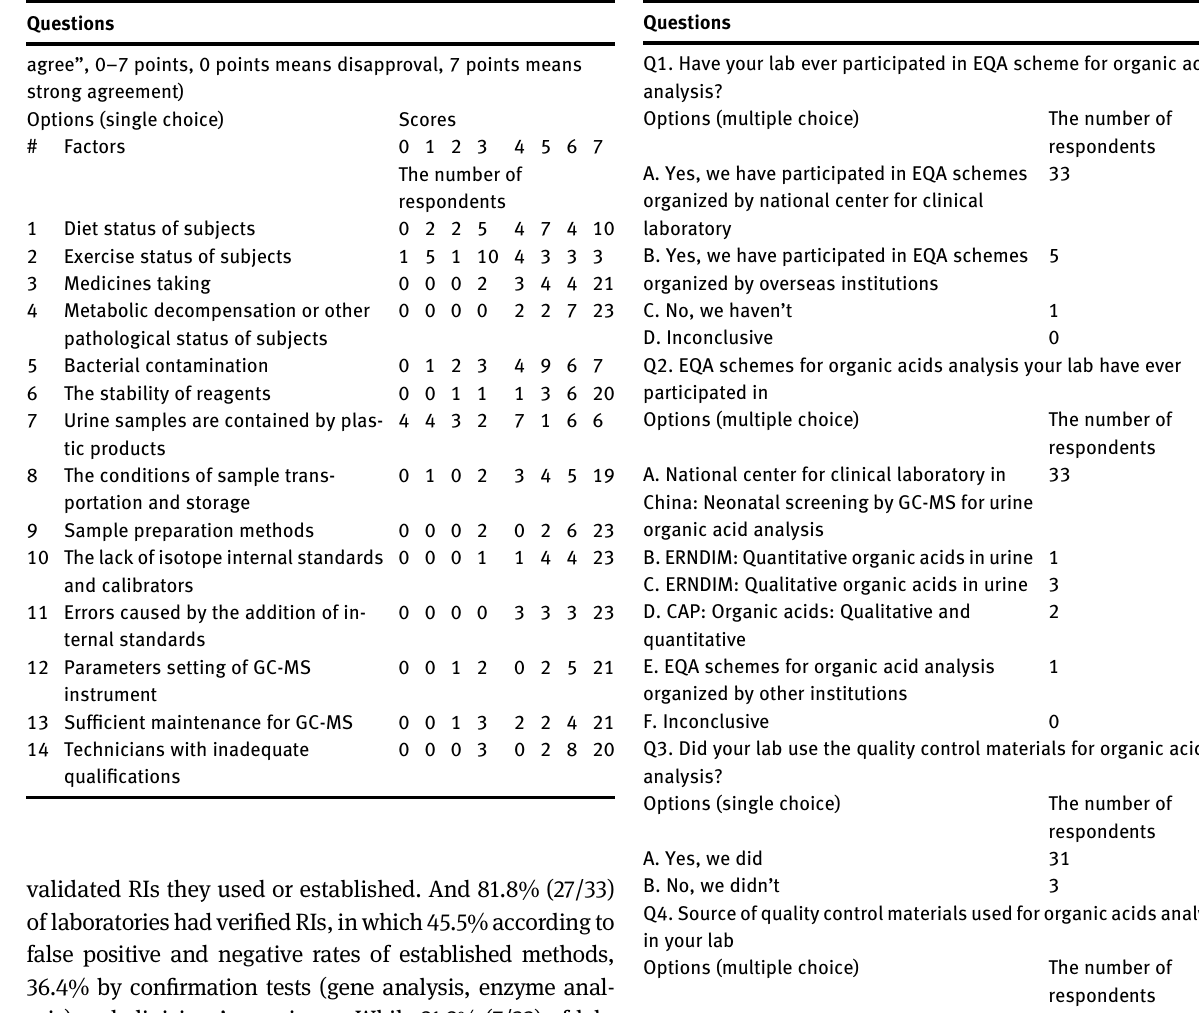
Table  : Quality assurances for organic acids